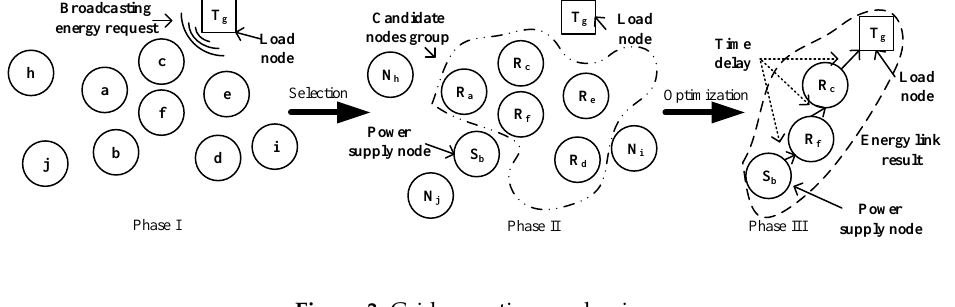
Figure 3. Grid operating mechanism.